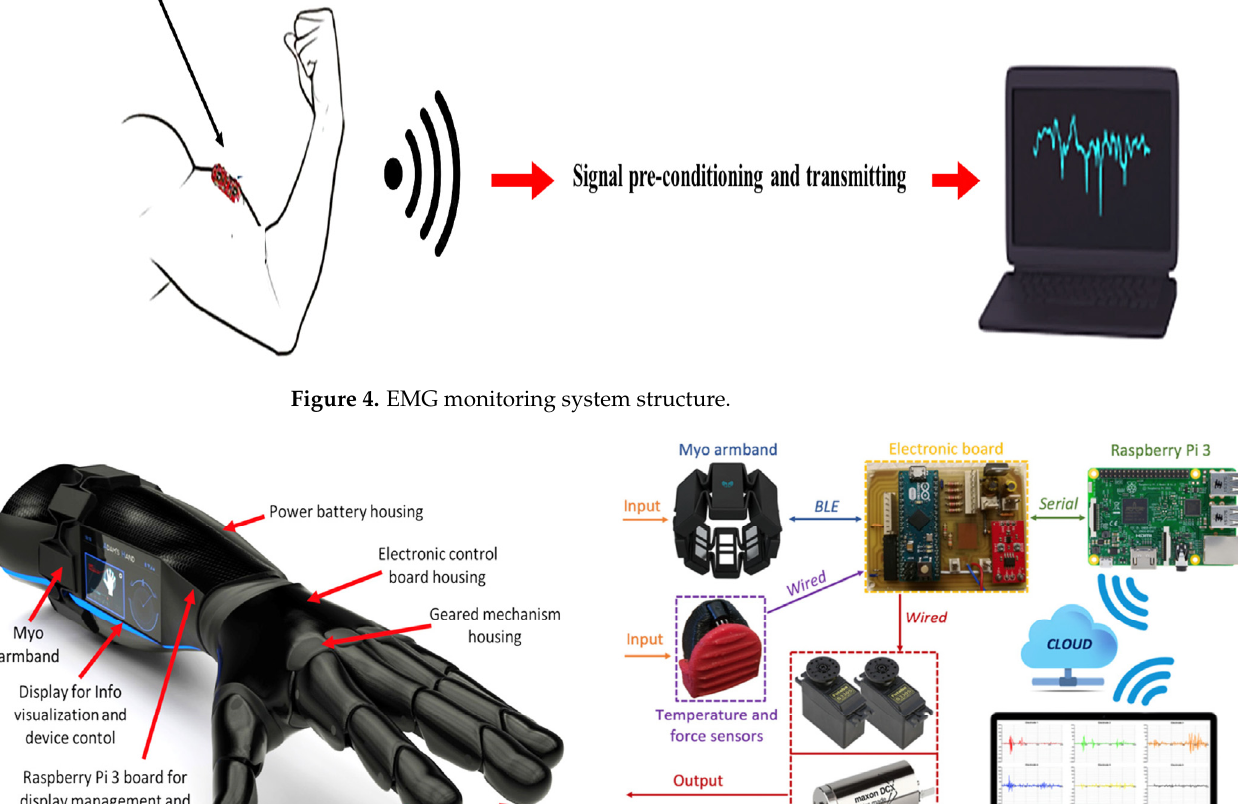
Figure 4. EMG monitoring system structure.